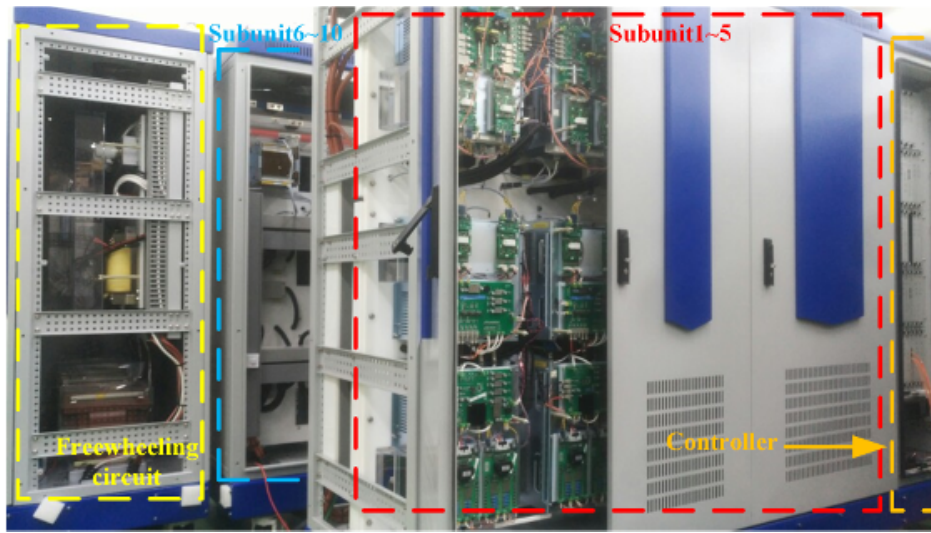
Figure 14. Single-phase 21-level SST